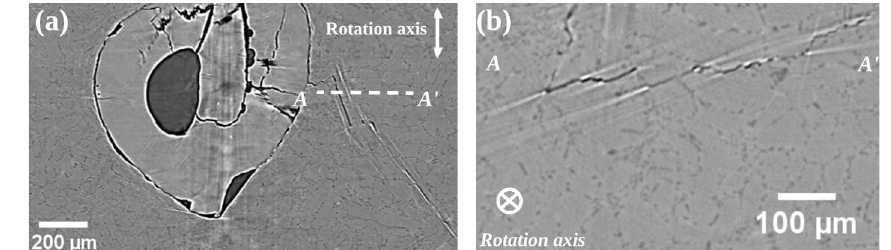
Figure 1. ( a ) Reconstructed image (vertical slice) of a fatigue crack within a cracked aluminum alloy sample obtained at SOLEIL (PSICHE beam-line) with an energy of 29 keV, a distance sample-detector of 15 cm and a voxel size of 1.3 µ m, the stress direction is parallel to the rotation axis; ( b ) Horizontal slice along the AA ′ dashed white line. In both slices dark lines correspond to voxels belonging to the crack, the brighter parts may be streak artifacts or flat cracks with small voxel